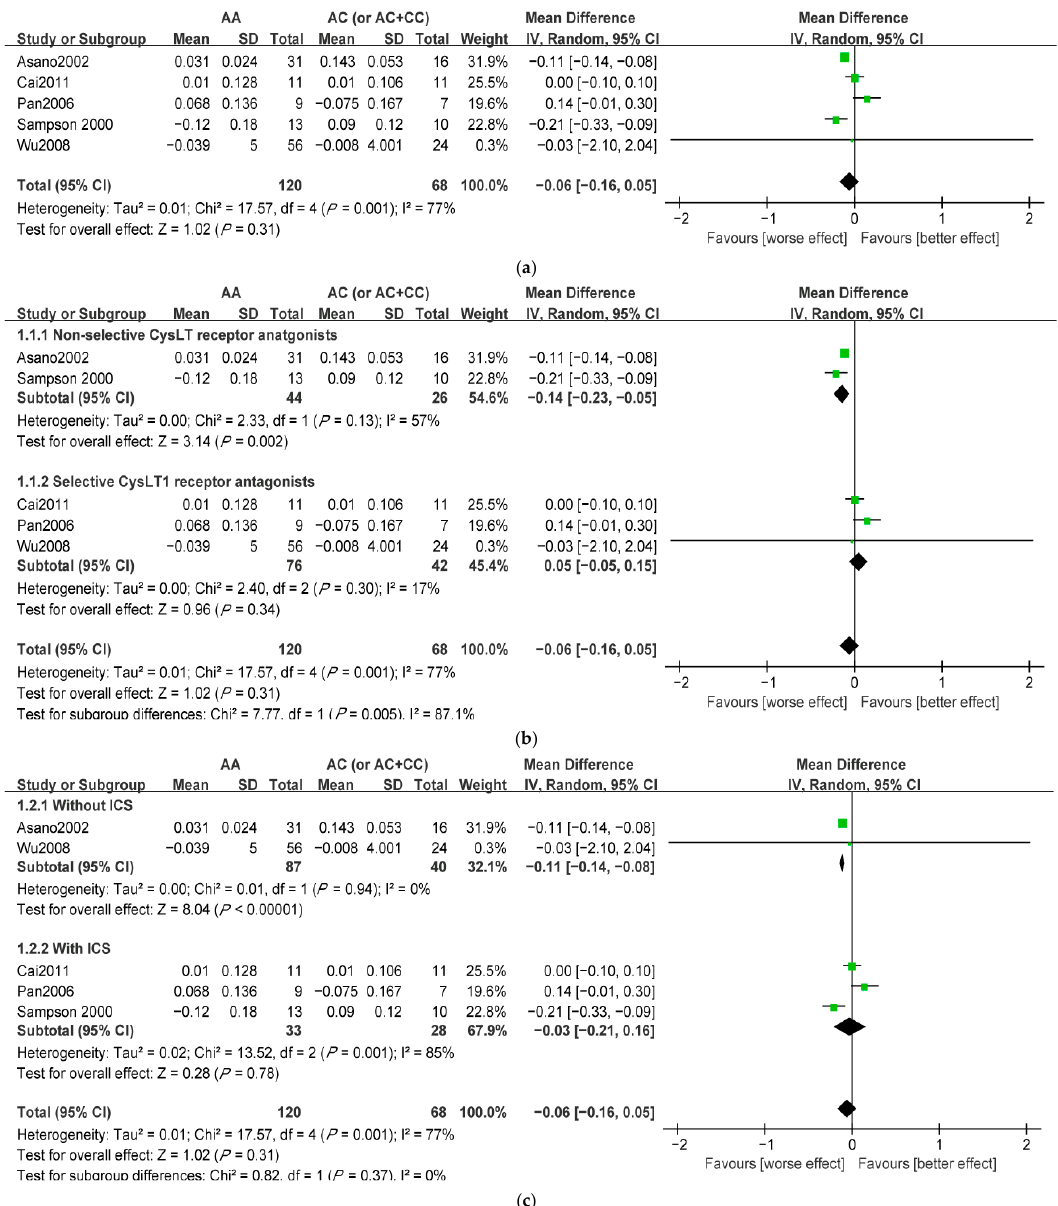
Figure 2. A meta-analysis was performed using random effects model for the association between improvement of lung function parameters and the LTC4S-444A/C polymorphism (AA vs. AC (or AC + CC)). ( a ) Ungrouped meta-analysis; ( b ) subgroup analysis for the types of drugs; ( c ) subgroup analysis for concomitant medication. The center of the green square represents the point estimate of the MD value of each study, and the size of the green square represents the weight of each study, the larger the weight the larger the square area. The length of the black line represents the range of 95% confidence intervals of the MD value for each study. The black diamond represents the combined effect of the meta-analysis for each study, the center of the diamond represents the MD value of the combined effect, and the width of the diamond represents the range of the 95% confidence interval of the combined